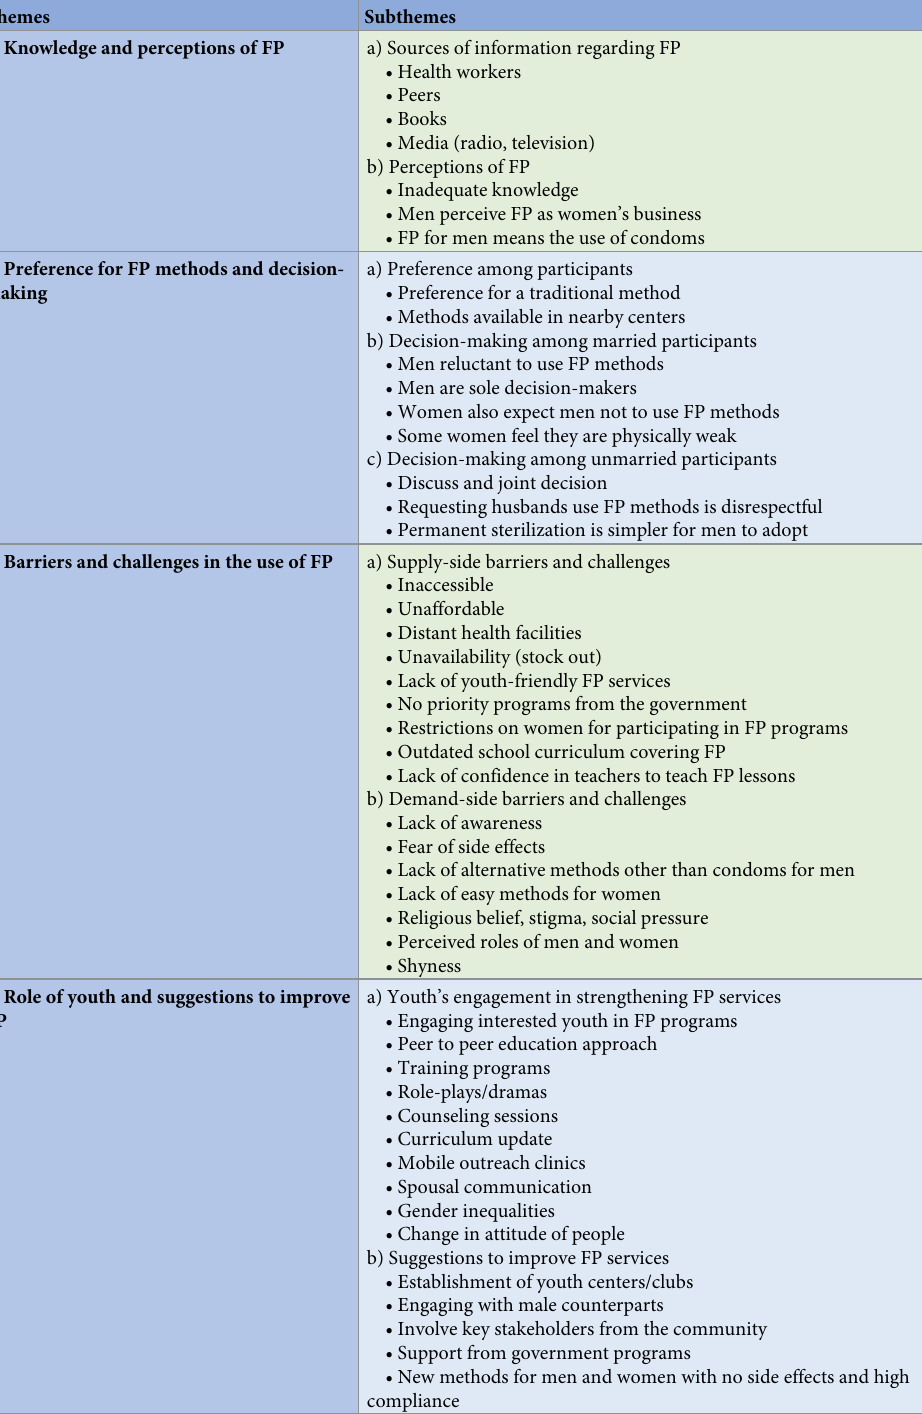
Table 2. Perceptions of FP services and its key barriers among